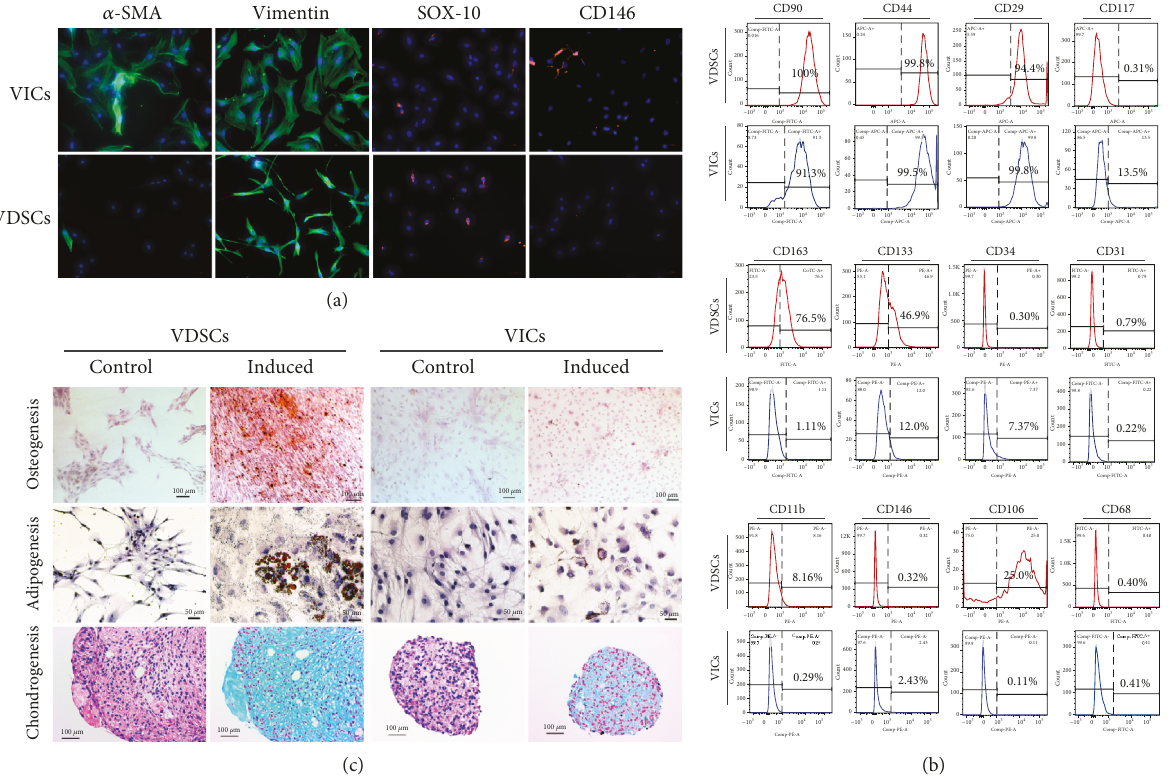
Figure 3: Comparative analysis of immunophenotype and di ff erentiation abilities on VDSCs and VICs. (a) Immuno fl uorescent staining for α -SMA, vimentin, SOX-10, and CD146 of VDSCs and VICs. Nuclei are stained with DAPI; scale bars: 50 μ m. (b) Flow cytometric analysis of mesenchymal markers of CD90, CD44, CD29, CD117, CD163, CD133, and CD146 and endothelial markers of CD34, CD31, and CD106 and also hematologic markers of CD11b and CD68 in VDSCs and VICs. (c) Osteogenic, adipogenic, and chondrogenic comparison of the VDSCs and VICs (Alizarin Red S staining for osteogenesis, Oil Red O staining for adipogenesis, hematoxylin staining for the nuclei, and Alcian blue for chondrogenesis); scale bars: 100 μ